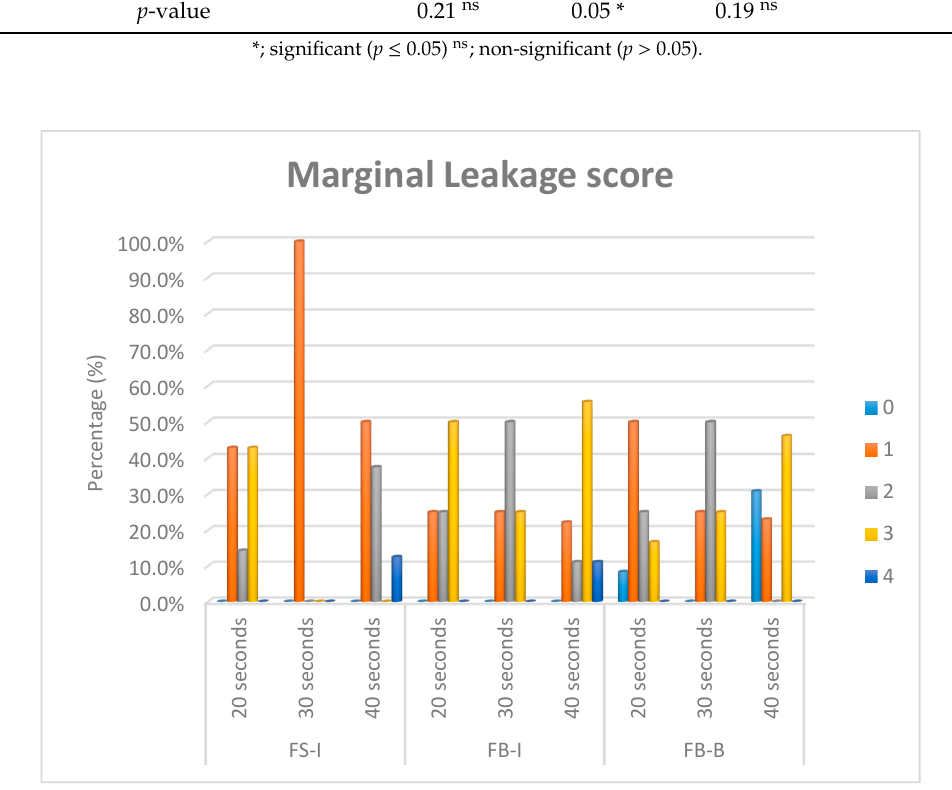
Table 4. Median (range) values of marginal leakage for different curing times and packing techniques. Packing Technique